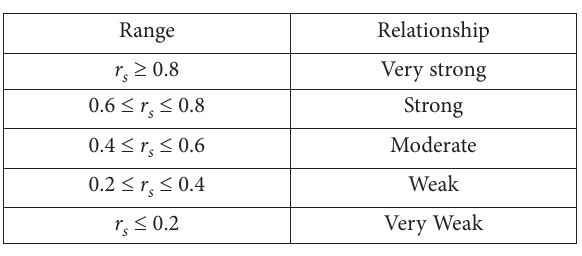
Table 15. Interpretation of the correlation coefficient values ( r s )